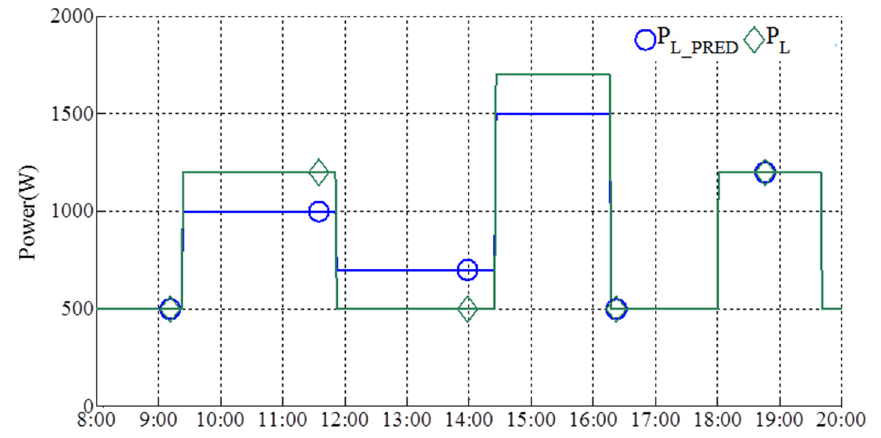
Figure 6. Load power prediction P L_PRED and load power demand P L for experimental